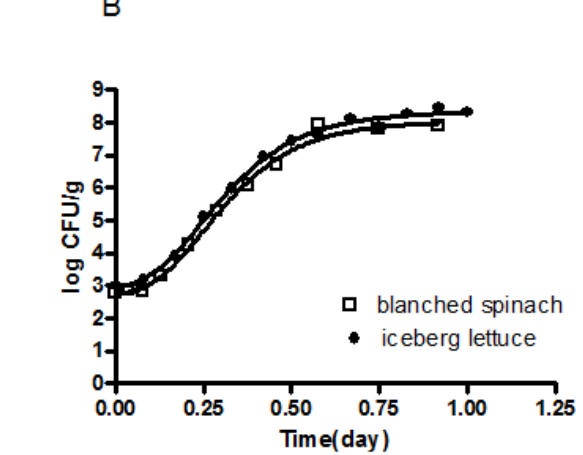
Figure 1. Representative primary growth model for E. coli O157:H7 NR in blanched spinach and fresh cut iceberg lettuce stored at ( A ) 24 and ( B ) 30